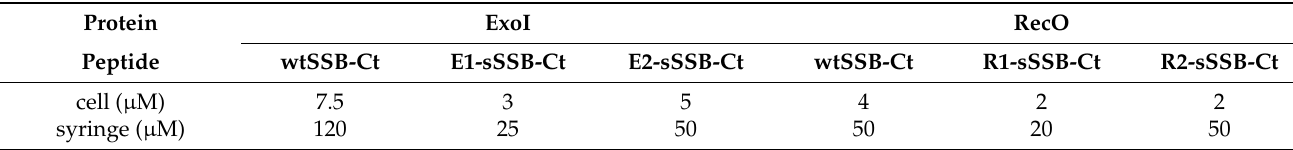
Table 1. Protein and peptide concentrations used in the ITC